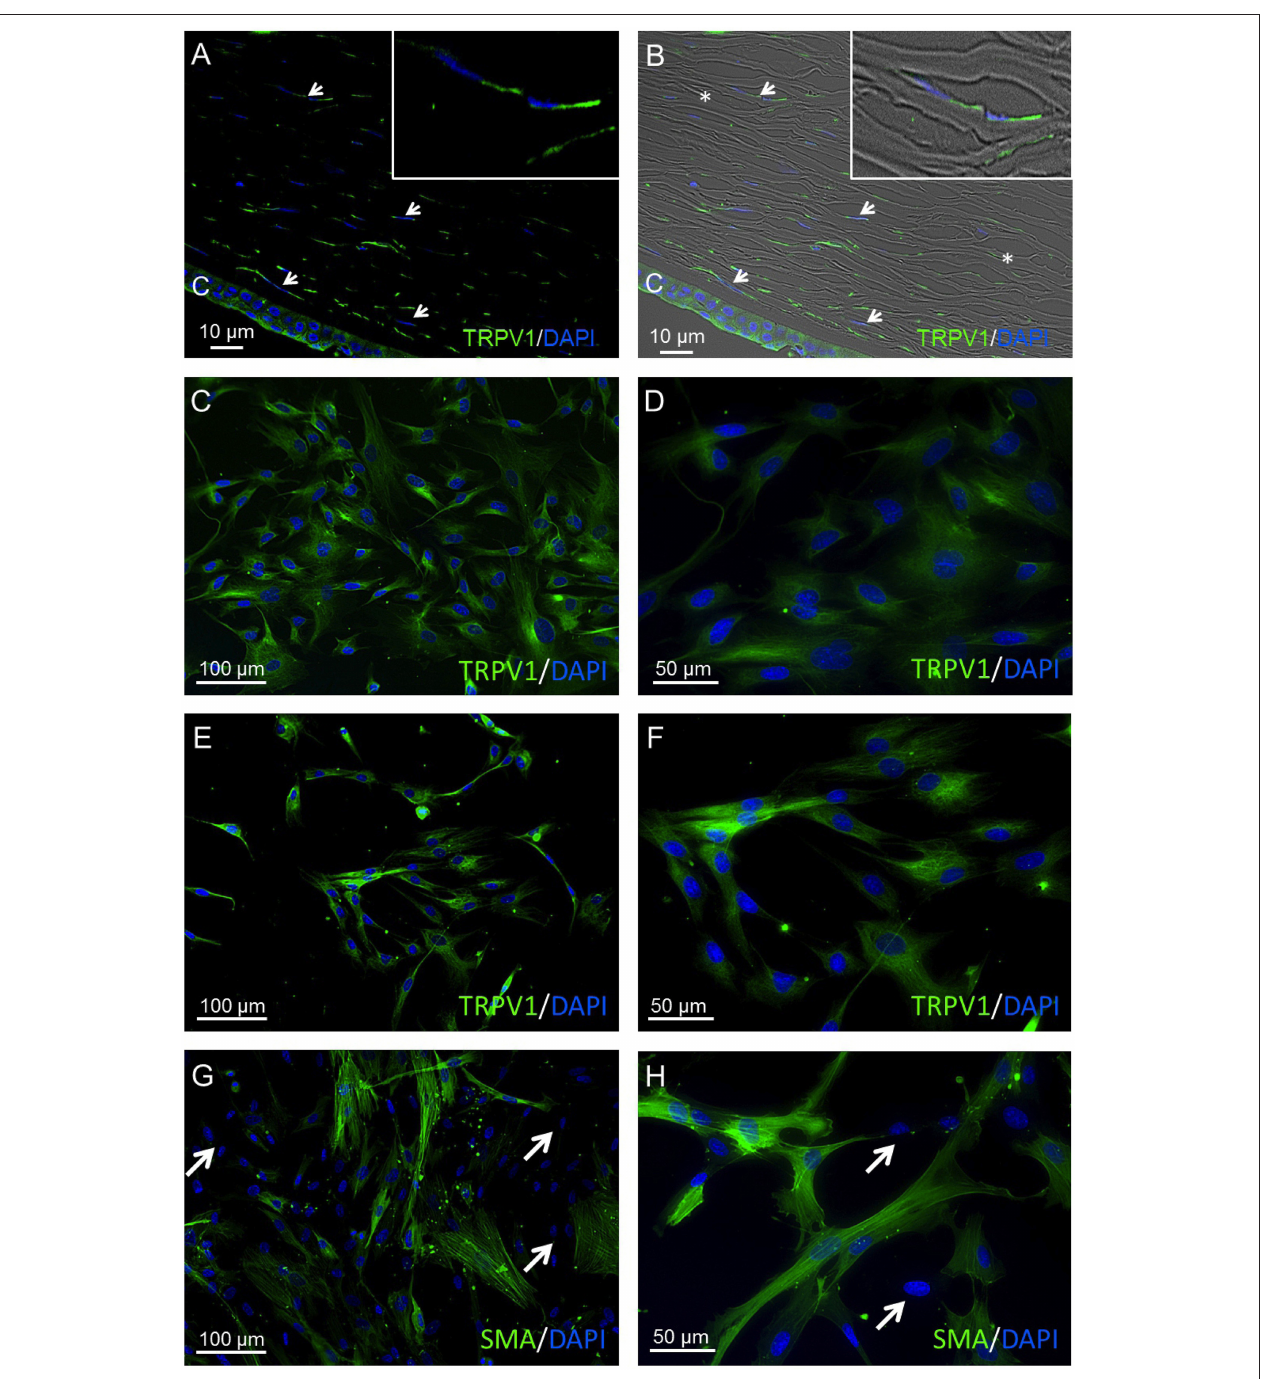
FIGURE 3 | TRPV1 protein expression in human cornea and primary human cornea fibroblast (pHCF) cells. IF analyses show TRPV1 (A,B) in human cadaver corneal cross sections. Stromal keratocytes (arrows) and corneal epithelial cells (CEC) clearly have a distinct subcellular origin (green). Cell nuclei were counterstained with DAPI (blue). The overlay of fluorescence with bright field picture (B) demonstrates parallel arrangement of the collagen fibrils (*) and the stromal keratocytes in between the lamellae. Inlays show higher magnification of stromal keratocytes. Pictures are representative of IF staining patterns from five cadaver corneas ( n = 5). IF analyses reveal TRPV1 expression in pHCF at passage 1 (C,D) and passage 5 (E,F) . (G,H) Anti- α -SMA antibody IF staining in primary human cornea fibroblast cells (passage 1). Arrows identify cells lacking IF staining signal. Notable, the green α -SMA IF staining pattern is partial and intense.